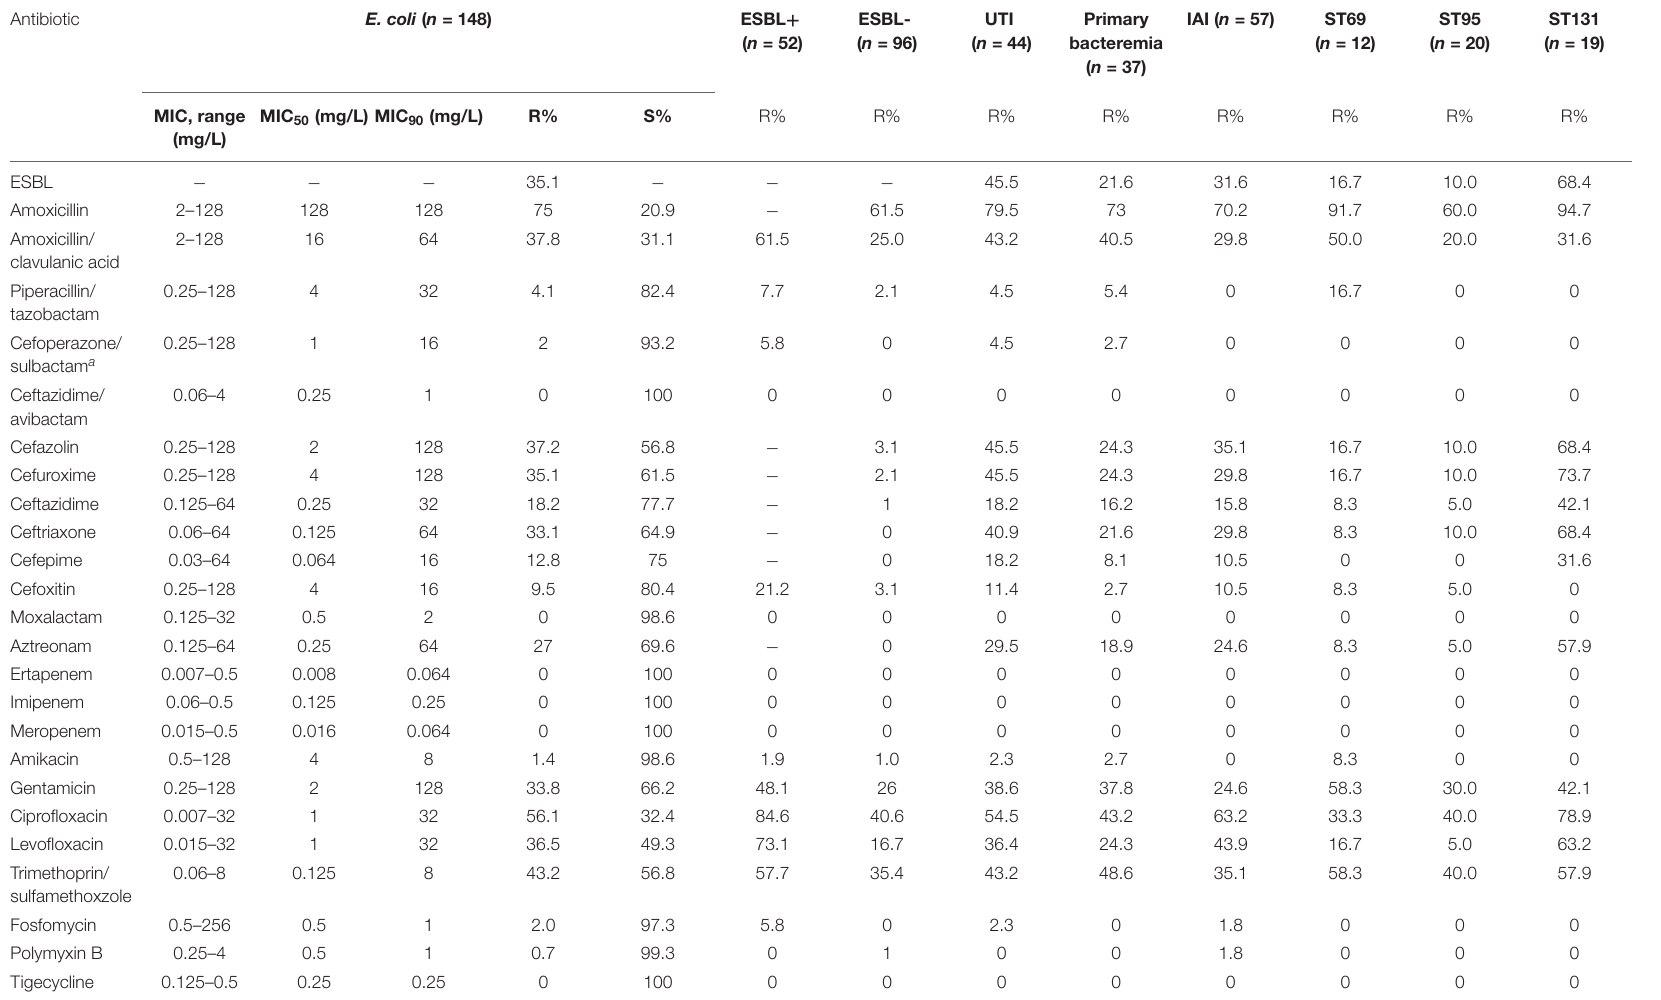
TABLE 2 | Antimicrobial susceptibility/resistance of E. coli isolates.